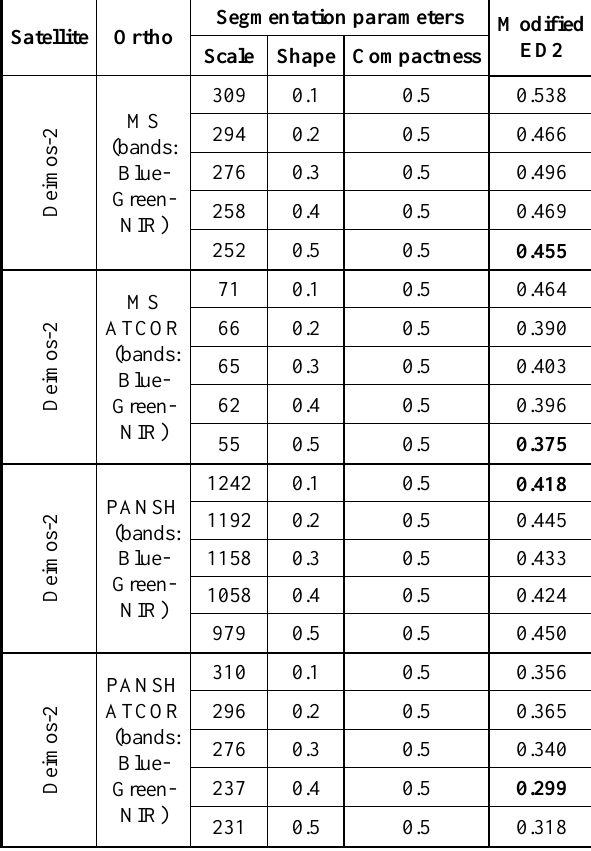
Table 1 . Optimal MRS outputs (i.e., minimum ED2 values) for the different orthoimages tested and every Shape